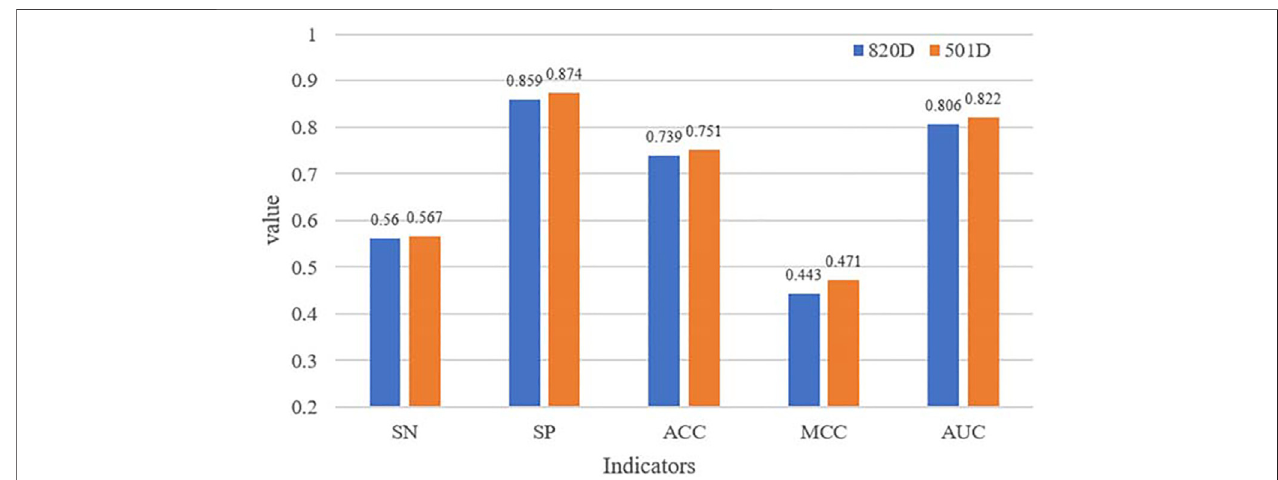
FIGURE 2 | Comparison of identi fi cation performance before and after dimensionality